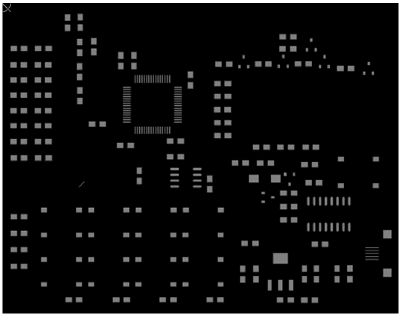
Figure 18. Distribution of solder joints on the circuit board.